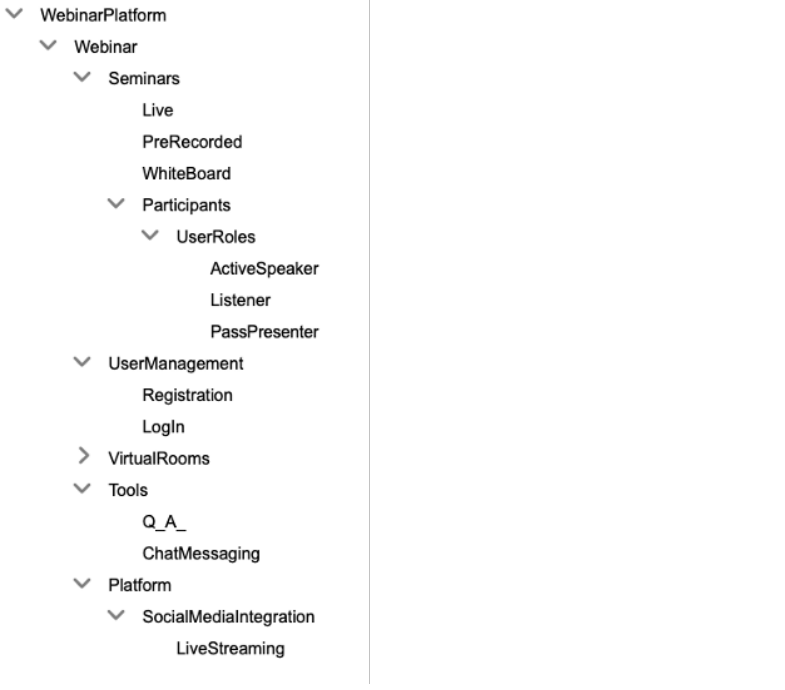
Figure 6. Variability model of webinar system domain.